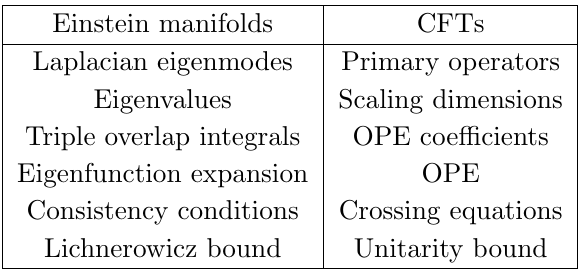
Table 1 . An analogy between Einstein manifolds and